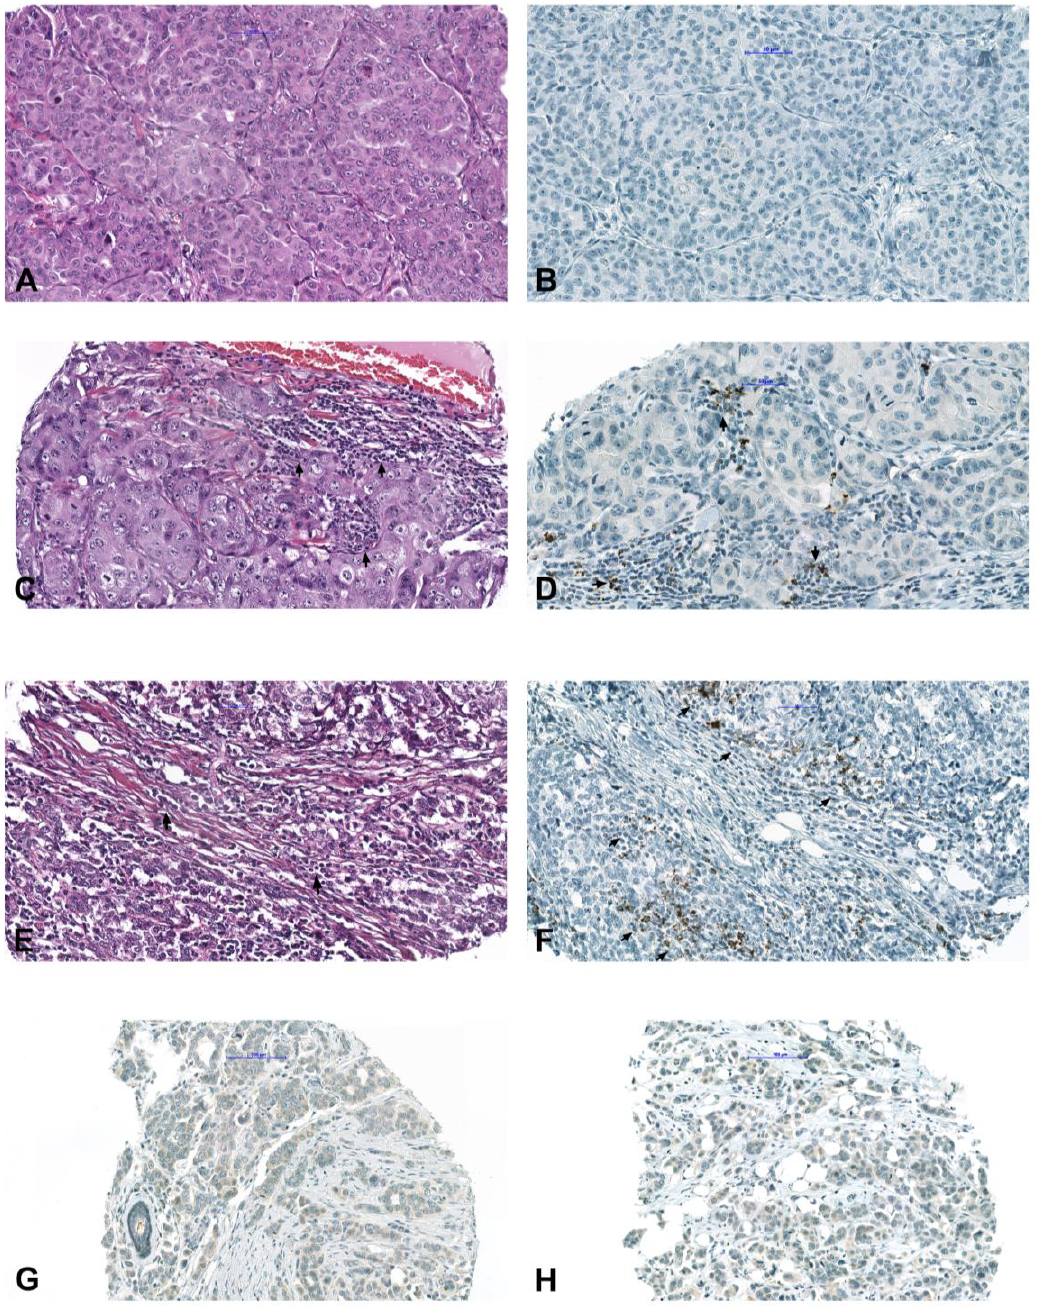
Figure 2. Immunohistochemical findings for PD-L1 and pan-TRK. ( A ). Invasive breast cancer without tumor-infiltrating immune cells (IC, magnification ×400) and ( B ) negative PD-L1 staining (magnification ×250. ( C , E ) Invasive breast cancer with focal (( C ) magnification ×335) and scattered (( E ) magnification ×250) tumor-infiltrating IC (arrows). ( D , F ) PD-L1 shows focal dark brown punctate staining in intratumoral single-IC or small aggregates (arrows) dispersed in >1% of tumor (magnification ×380). ( G , H ) Tumor cells show weak cytoplasmatic pan-TRK expression (magnification ×200).